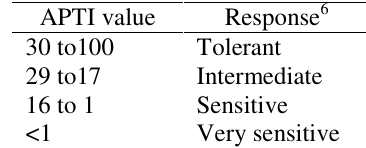
Table 2. Air pollution index values and plant response to pollution